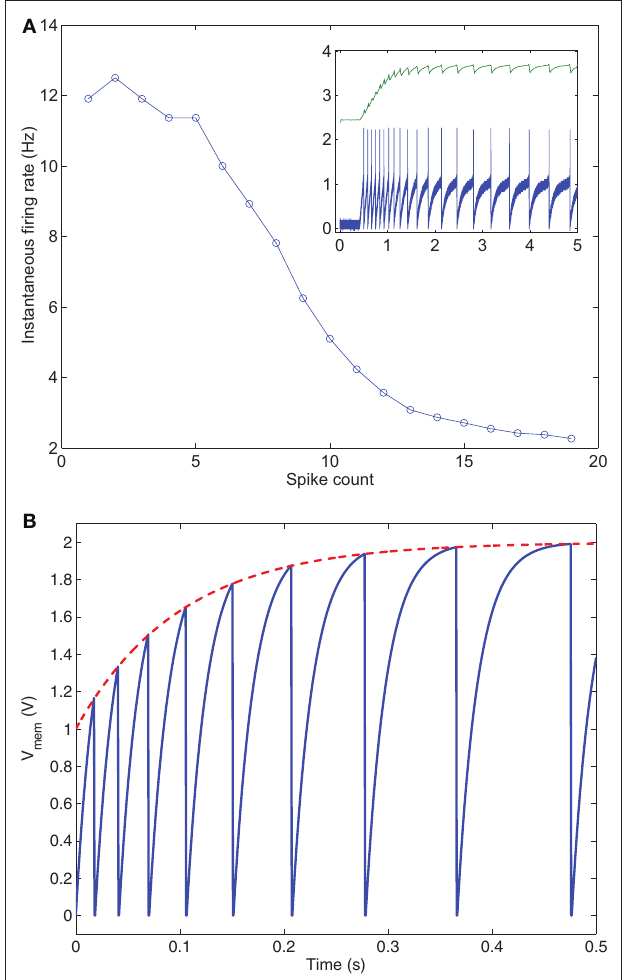
FIgure 5 | Spike-frequency adaptation is a SiN. (a) Negative slow ionic current mechanism: The plot shows the instantaneous firing rate as a function of spike count. The inset shows how the individual spikes increase their inter-spike interval, with time. Figure adapted from Indiveri et al. (2010). (b) Adaptive threshold mechanism: The neuron’s spiking threshold increases with every spike, therefore increasing the inter-spike interval with